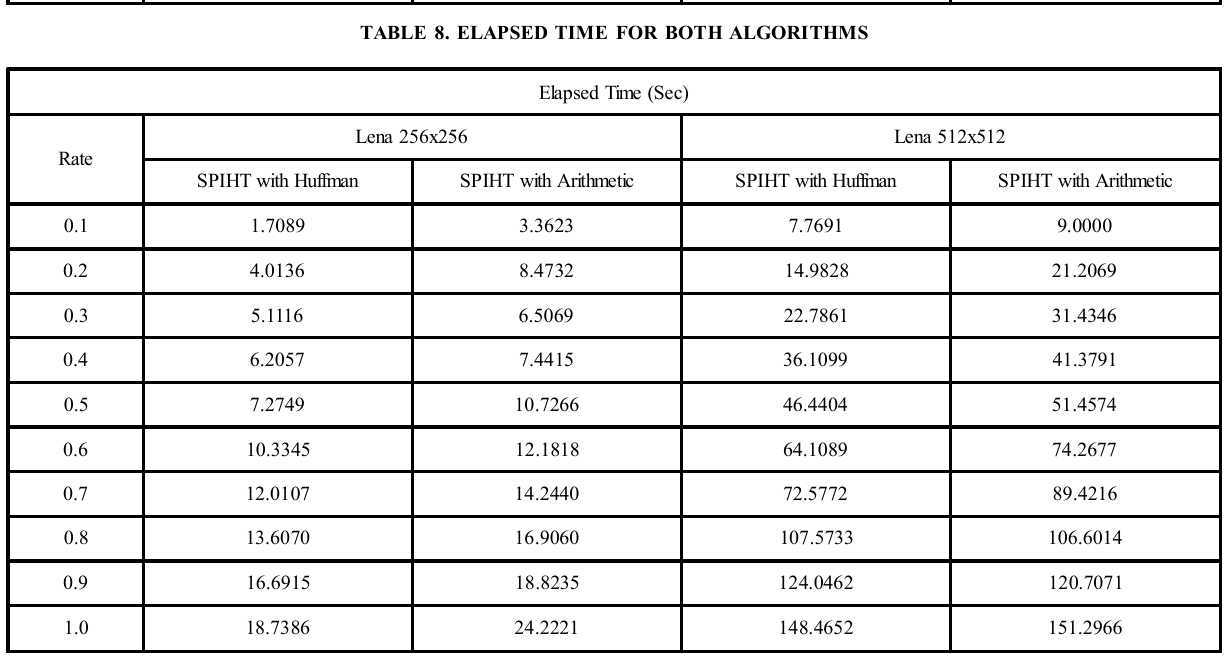
TABLE 8. ELAPSED TIME FOR BOTH